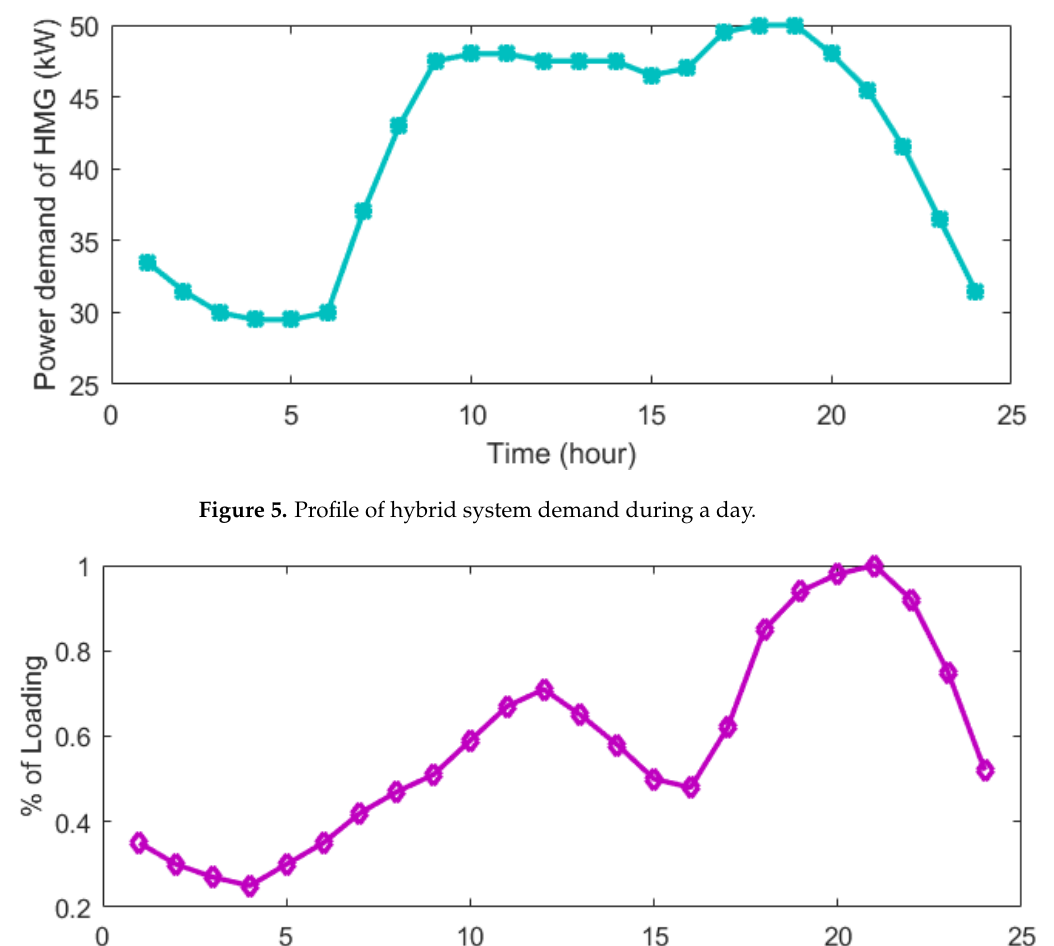
Figure 4. Profile of wind speed during a day.